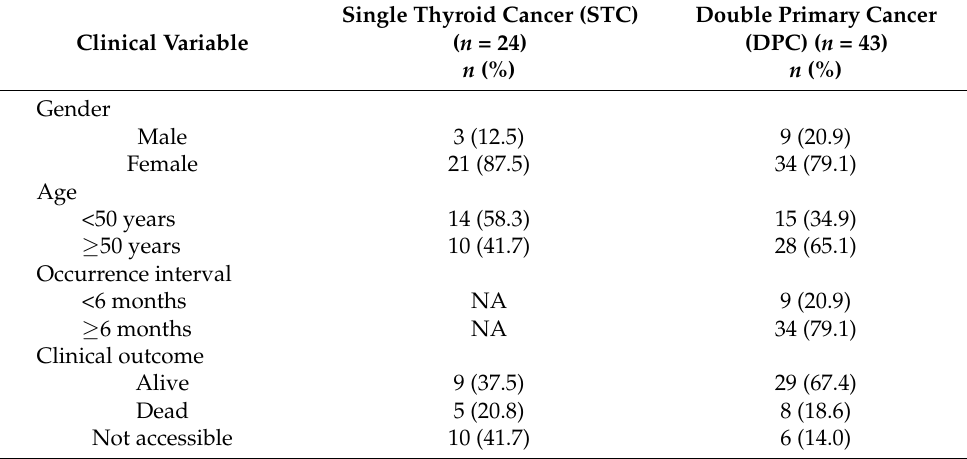
Table 1. Basic demographics of study